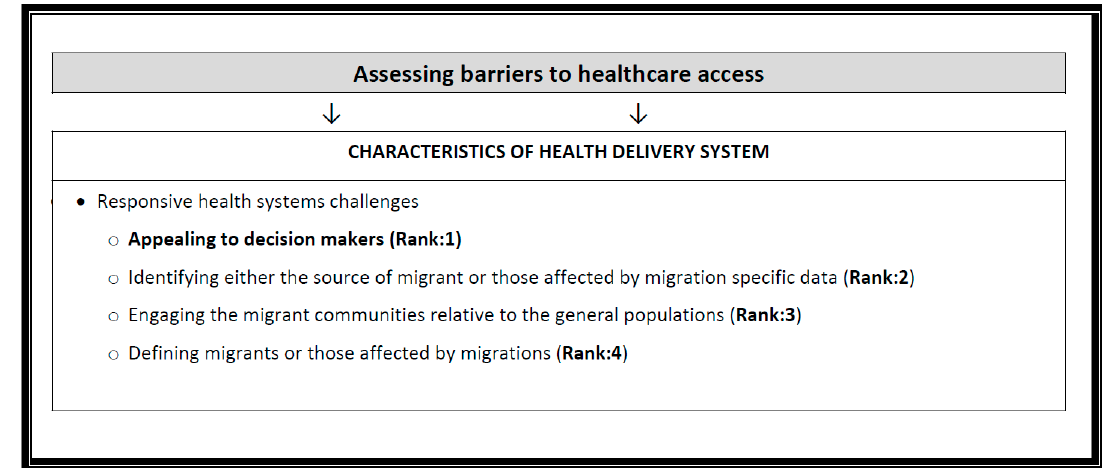
Figure 2. Priority ranked results on health system challenges and characteristics of disadvantaged